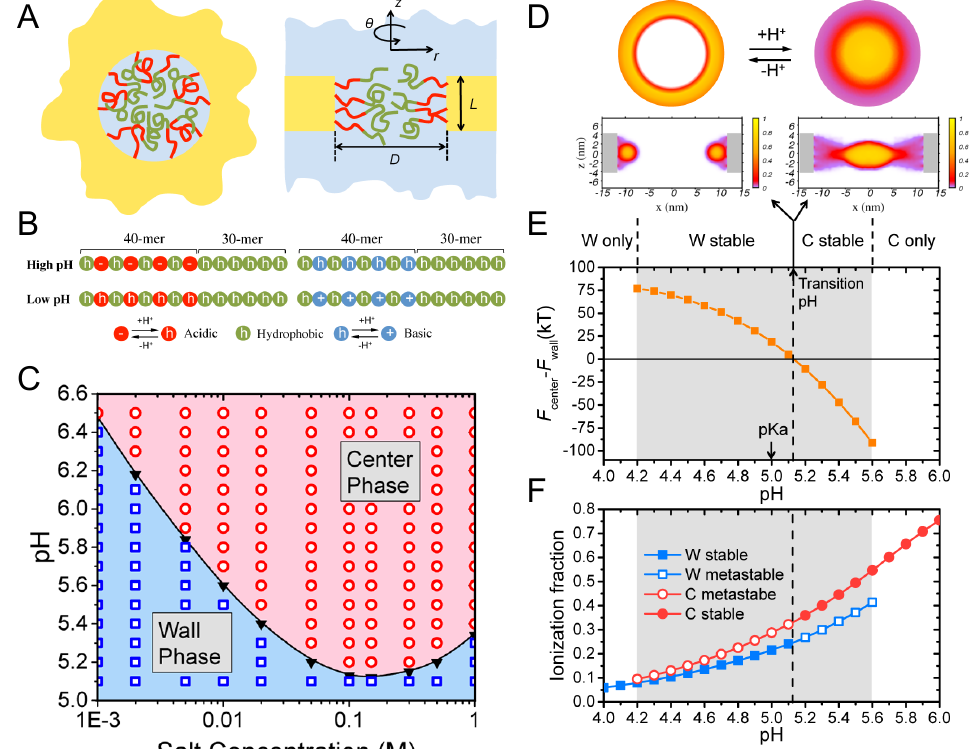
Figure 11. Design of copolymer for smart (stimuli-responsive) nanopore. ( A ) Schematic representation of the copolymer grafted short nanopore. ( B ) Sequence design of the copolymer. The copolymer contains in total 70 monomers, which can be classified into two groups according to their ionizability. The ionizable ones are hydrophilic when charged and hydrophobic when they are neutral. ( C ) Phase diagram of the nanopore. ( D ) Switching between center and wall phases at the transition pH. ( E ) Free energy difference between the two phases and the metastable regime. ( F ) Ionization fraction of both phases within the metastable regime. (Reprinted with permission from the authors of